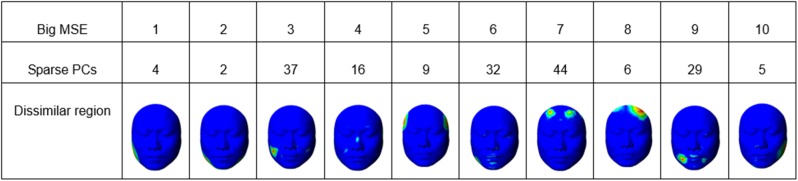
The regions with dissimilarity between F2 and F53 by SPCA sparse principal components.